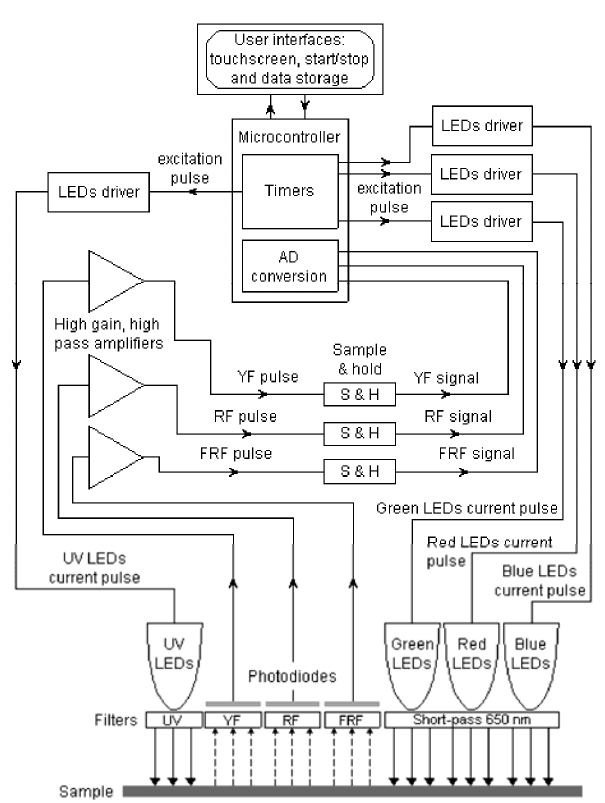
Figure 2. Block diagram of the Multiplex ®